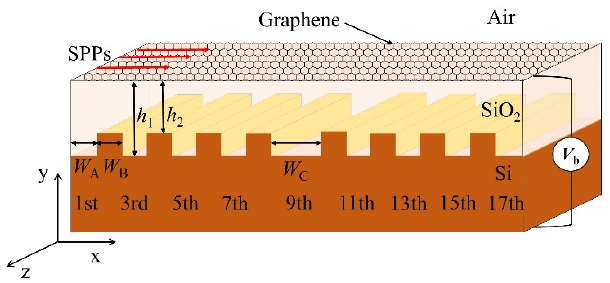
Figure 1. Three-dimensional schematic diagram of the proposed graphene